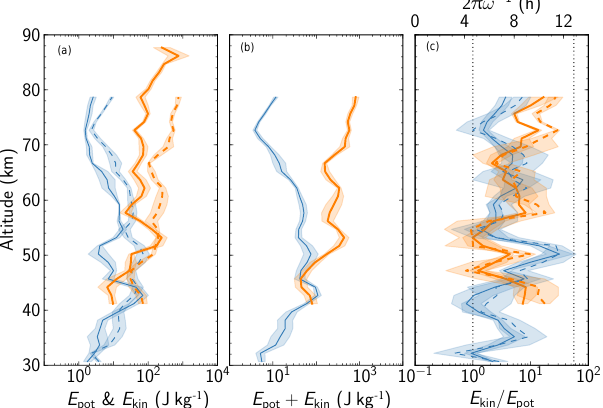
Figure 6. Gravity wave energy densities per unit mass and the in- trinsic period (2 π ˆ ω − 1 ) a monochromatic gravity wave with the given kinetic-to-potential GWED ratio would have, for the night of 20/21 January 2015; lidar (orange); ECMWF (blue). Panel (a) : po- tential (solid) and kinetic (dashed) GWED. Panel (b) : total GWED. Panel (c) : kinetic-to-potential GWED (solid) and 2 π ˆ ω − 1 (dashed); the dotted vertical lines denote unity and 2 πf − 1 , respectively. Shading represents the corresponding